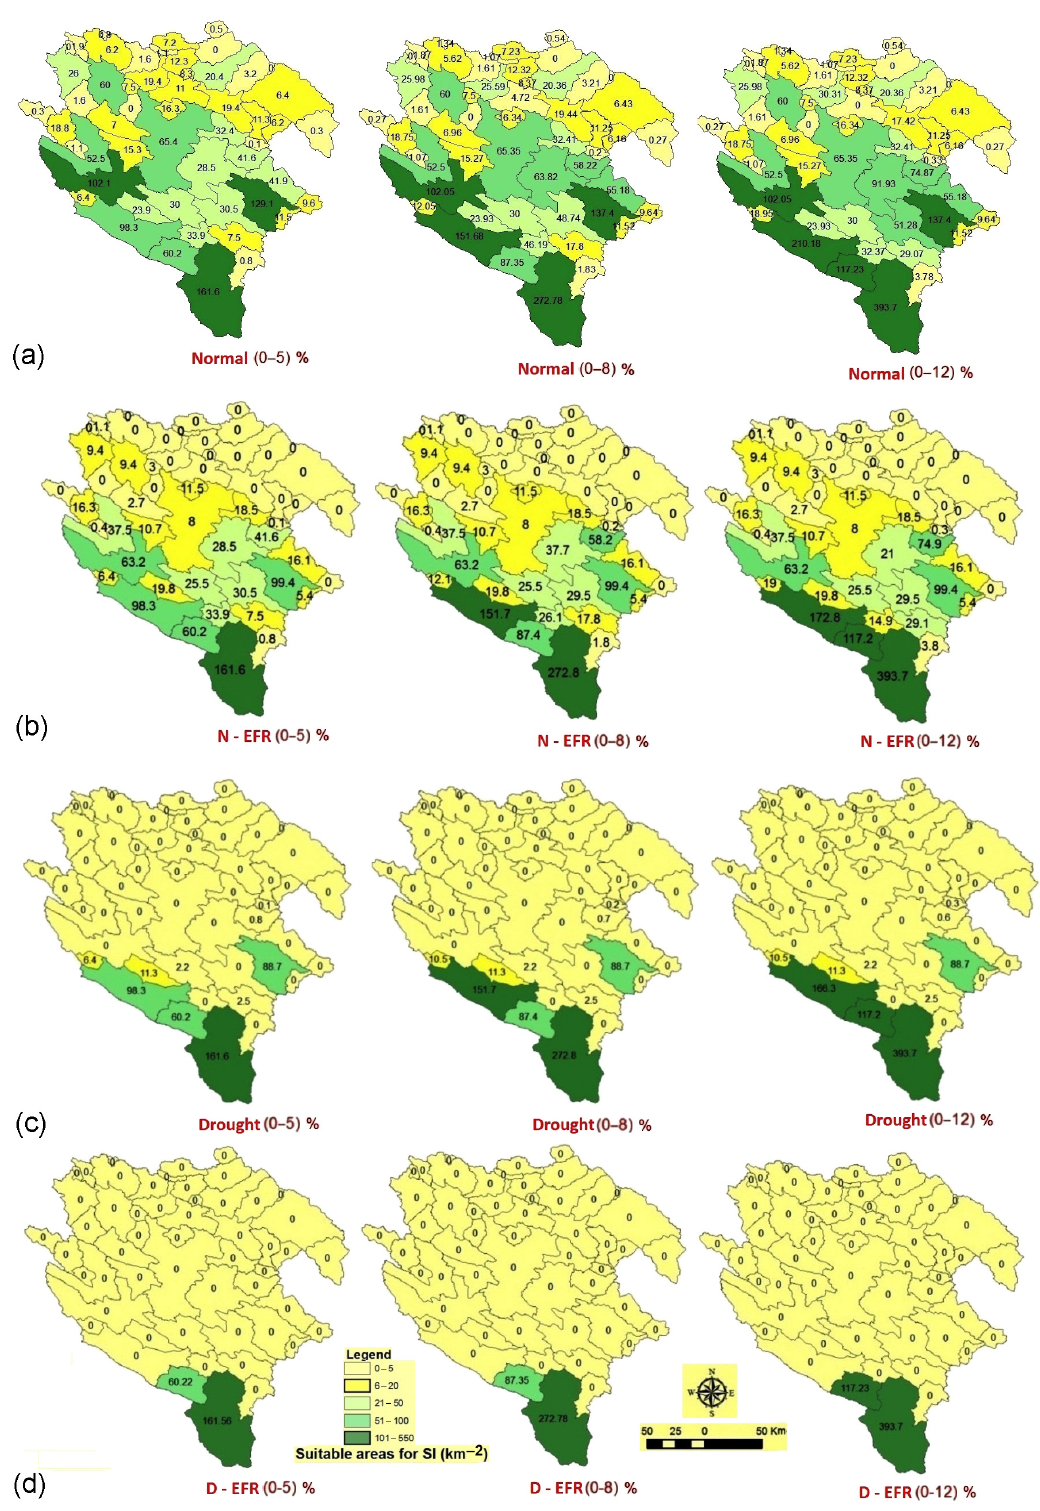
Figure 4. Areas that could receive supplemental irrigation in autumn and spring in the 53 sub-basins of Karkheh River basin, for three slope classes and four flow scenarios (normal flow, normal with environmental flow requirements (EFRs), drought conditions, and drought with